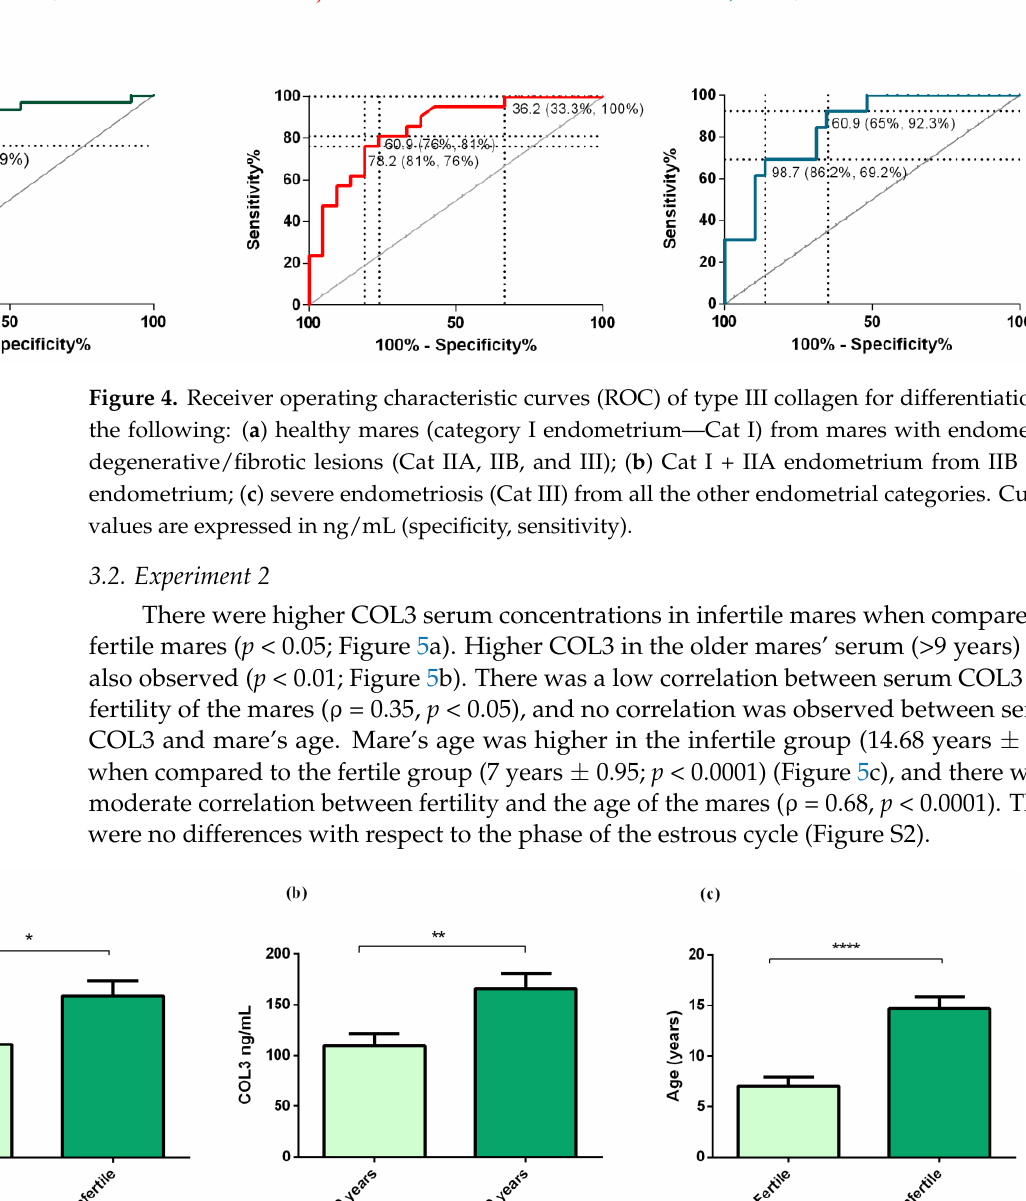
Figure 6. Receiver operating characteristic curves (ROC) of serum type III collagen for differentia- tion of fertile from infertile mares. Cut-off values are expressed in ng/mL (specificity, sensibility). 4. Discussion In humans, many studies are being conducted to find diagnostic and prognostic fi- brotic biomarkers for cardiac [40,41], renal [42], and hepatic fibrosis [37,38,43], among many others [32]. Biomarkers may be used for early detection of otherwise subclinical disease, diagnostic assessment of an acute or chronic clinical syndrome, risk stratification of patients with a suspected or confirmed diagnosis, prognosis, and selection of an appro- priate therapeutic intervention, and monitoring the response to therapy [41]. As an exam- ple, a study in abdominal aortic aneurysm in humans, higher amounts of hydroxyproline, COL1, and COL3 were found in samples of patients compared with healthy controls, and a positive correlation was found between tissue and serum concentrations of COL1, and